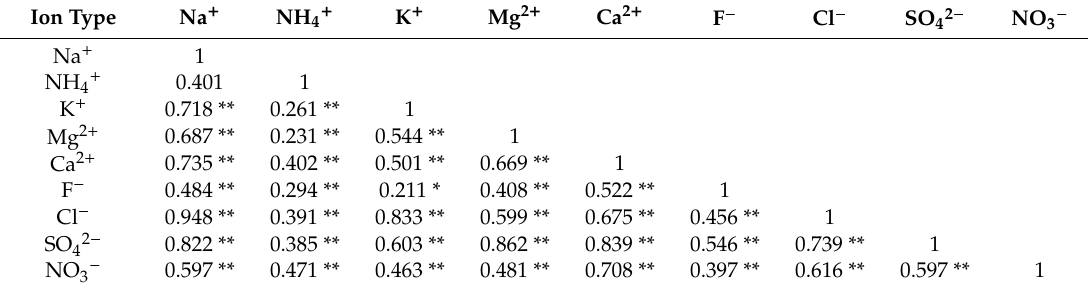
Table 5. Pearson correlation